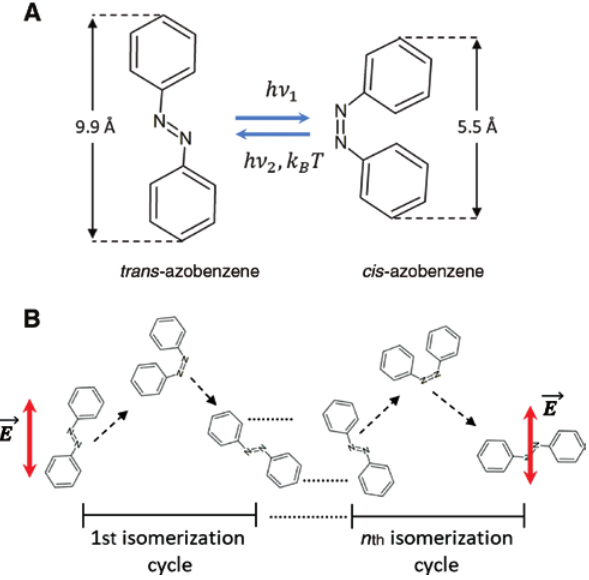
Figure 1: Molecular photo-dynamics of the azobenzene. (A) The structural conformation of two isomers of azobenzene. (B) Schematic illustration of the stochastic photo-alignment process of the azomolecules irradiated by linearly polarized light. The direc- tion of molecular alignment is determined by the direction of the (cid:31) electric vector E in the irradiating optical